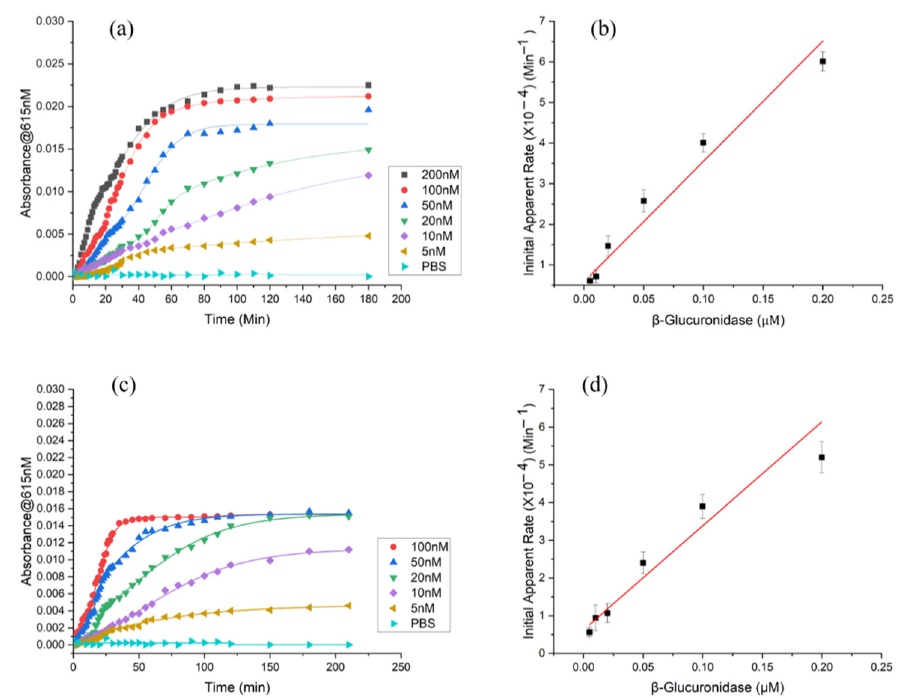
Figure 9. Kinetics recorded as absorbance at λ max = 615 nm for the β -glucuronidase sensing using ( a ) NFs and ( c ) hydrogel and estimated initial apparent rate of reaction for the first minutes from linear least-squares fit for ( b ) NFs and ( d ) hydrogel (error bars: standard error of mean for n = 2, R 2 = 0.969 for NFs and 0.940 for CS/PEO HG).